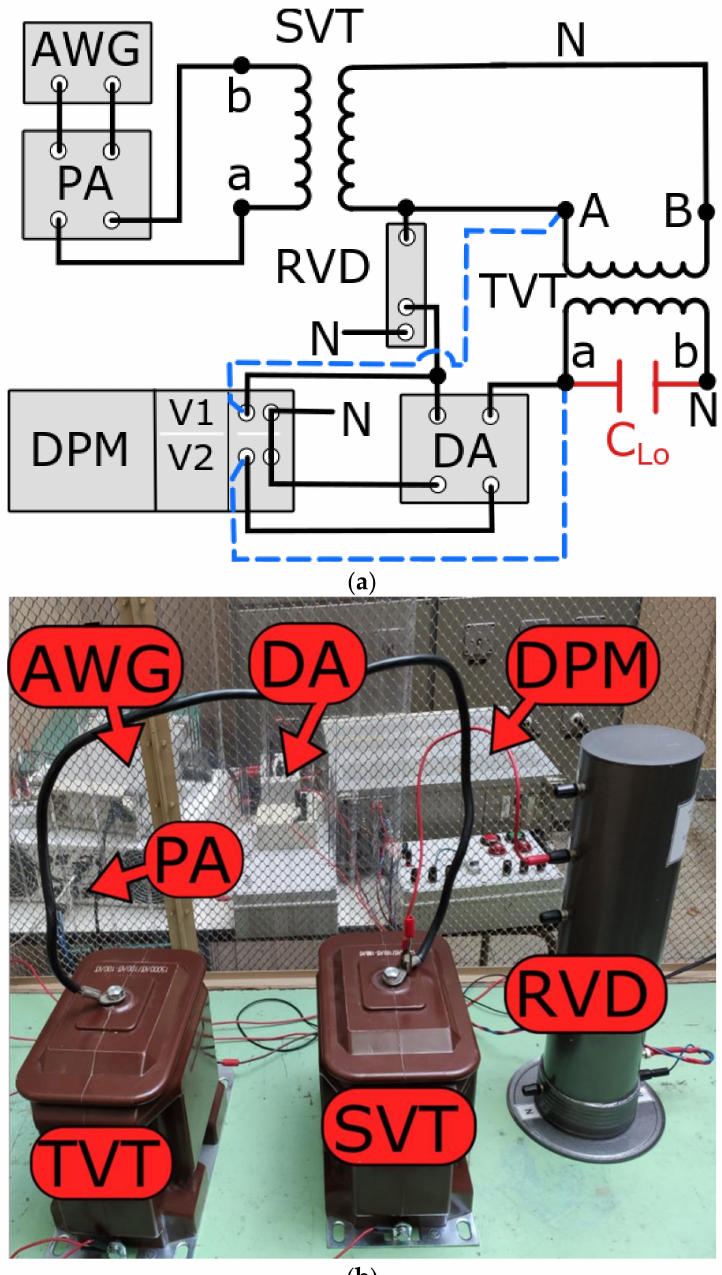
Figure 1. The laboratory setup: ( a ) diagram, ( b ) photo. The laboratory setup presented in Figure 1 has two configurations. The first one (black solid lines, Figure 1a) is used for evaluation of the transformation accuracy of the non-sinusoidal voltage by tested VT (TVT). The measurement uncertainty of this devel- oped differential method for testing the transformation accuracy of harmonics of distorted voltage by medium-voltage instrument transformers is discussed in the paper [17]. The expanded combined measurement uncertainties of the values of ratio error and phase dis- placement with the coverage factor equal to 2 (level of confidence of about 95%) determined in this case for ± 0.1% \± 0.1 ◦ are equal to